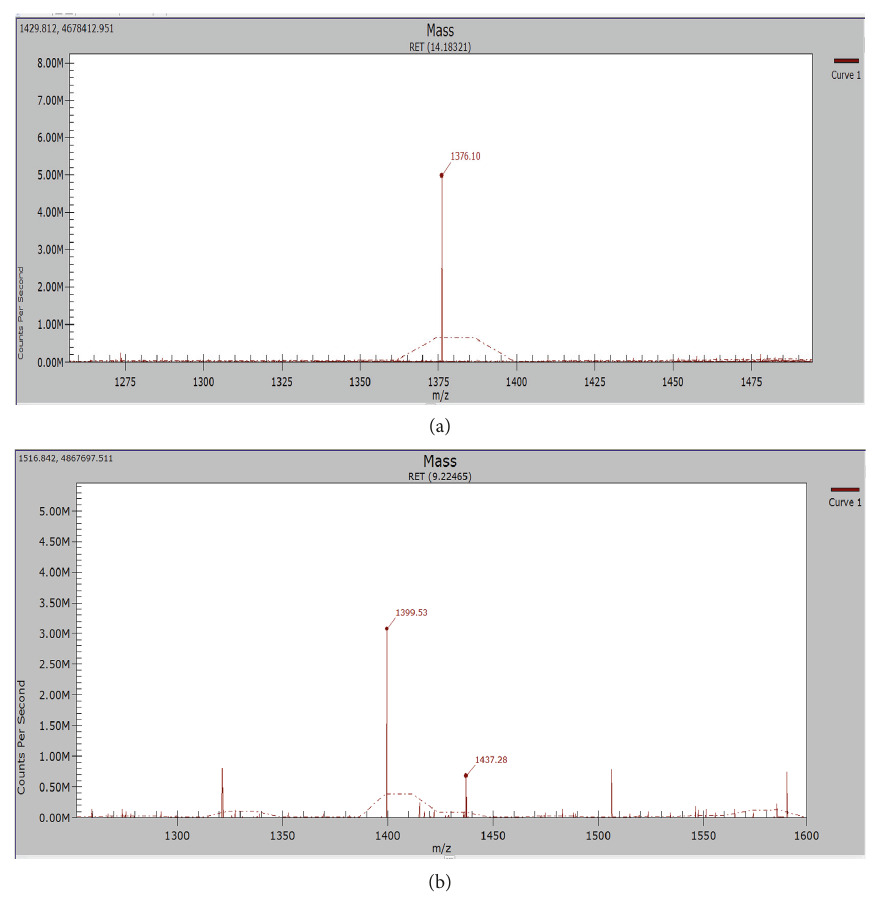
Figure 3: Mass spectrum analysis of peptide synthesis products by liquid chromatography coupled to mass spectrometry (LCMS). (a) Synthetic peptide 1 (P1). (b) Synthetic peptide 2 (P2).